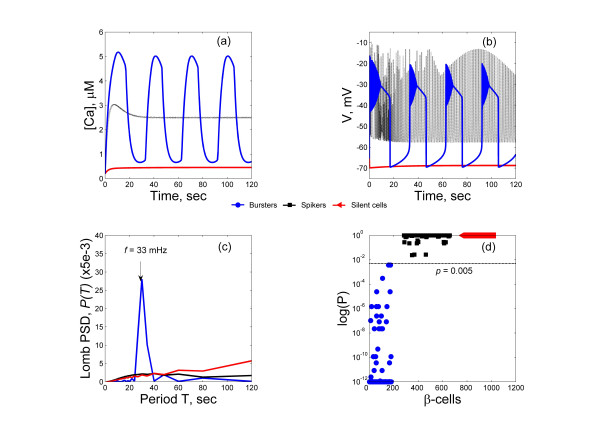
Cell sorting using Lomb-Scargle periodogram. (a) Calcium profiles, (b) membrane action potential profiles, and (c) Lomb-Scargle periodogram, of a burster cell, a spiker cell and a silent cell. The burster has a clear peak frequency at f = 33 mHz (0.033 sec-1), whereas the spiker and silent cells have broad spectra. (d) Distribution of the principal peak p values. All cells with p < 10-12 were plotted at p = 10-12. The burster cells form a distinct group from others, with p < 0.005 (dashed black line).